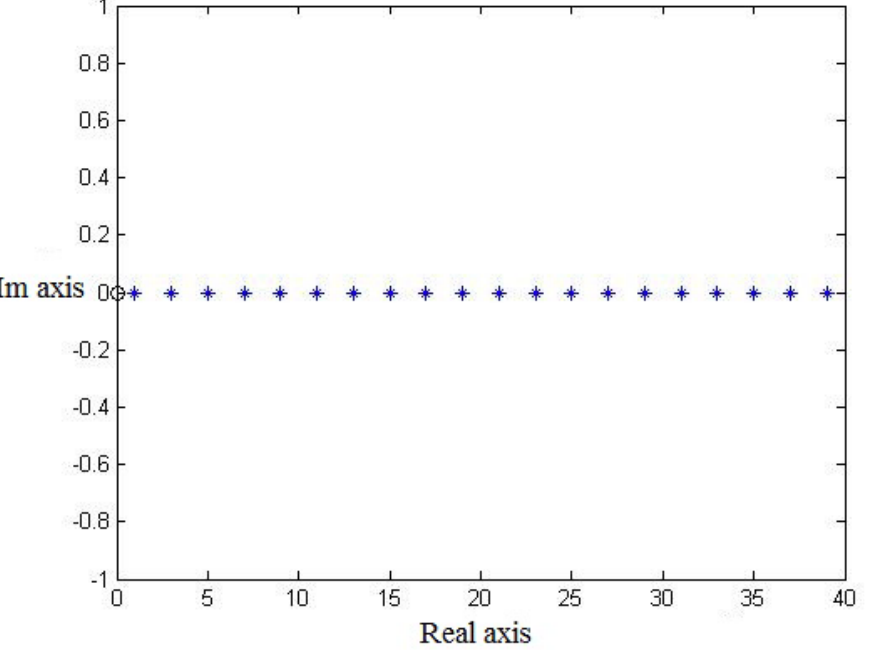
Figure 6. Energy eigenvalues of the PDM Hamiltonian associated with single potential for 01.0 =λ .